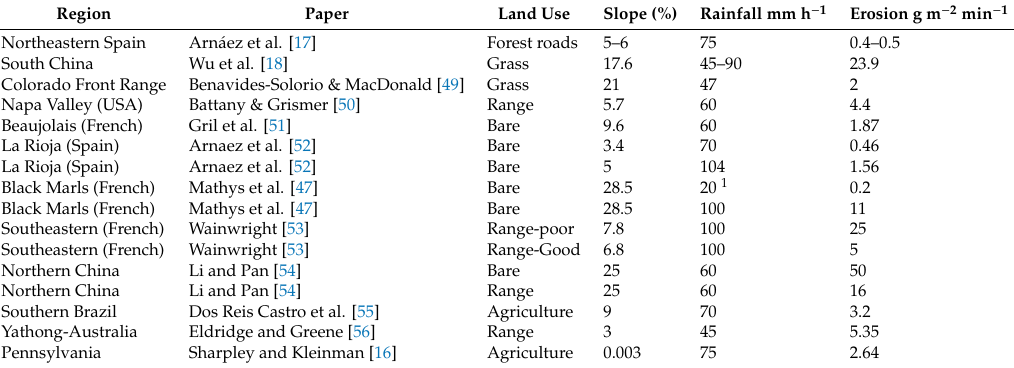
Table 1. The observed soil erosion in di ff erent regions using the rainfall simulator